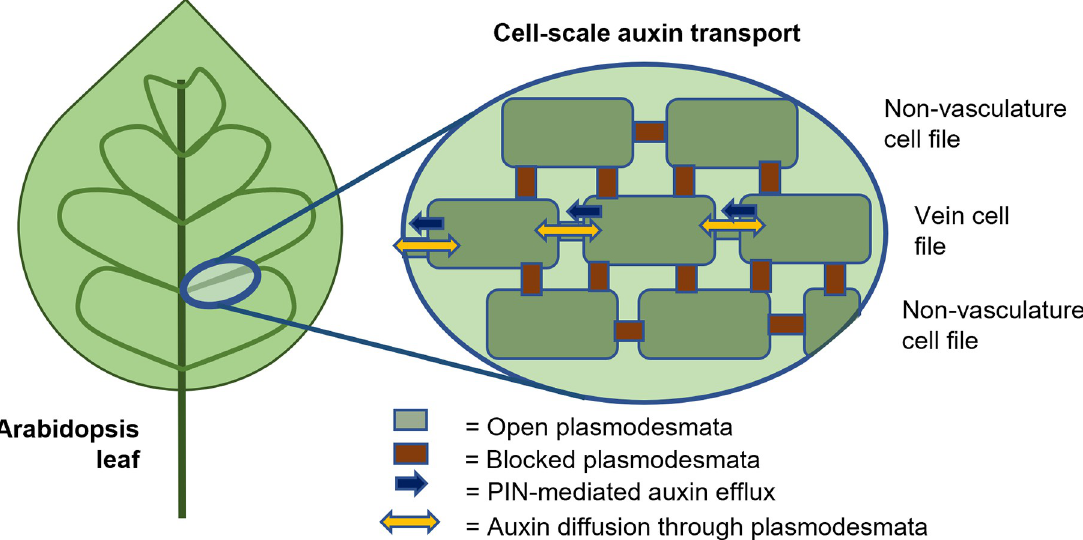
Fig 1. Schematic of key components of auxin transport governing leaf vein formation. Linh and Scarpella [5] show that in addition to polarised PIN1-mediated auxin transport within vein cell files, open plasmodesmata enable diffusion between adjacent vein cells. Their study reveals that diffusion of an auxin signal through plasmodesmata is essential to leaf vein patterning in Arabidopsis .